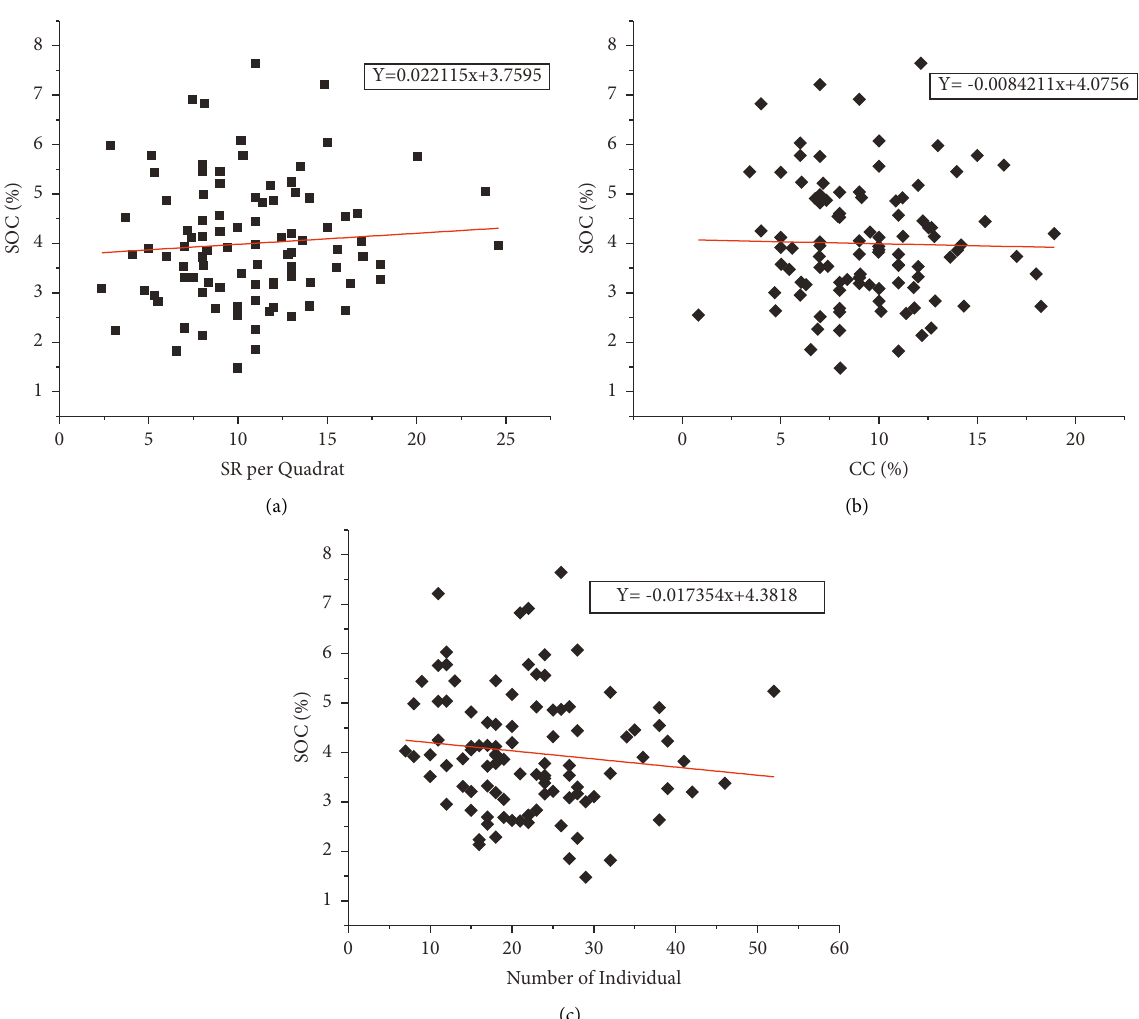
Figure 4: Response of mean SOC (%) against stand structural attributes (CC% � canopy cover percent, number of individuals per plot, SR � plot species richness, x � the independent variable on x -axis, y � the response variable on the y -axis); the dot and line represent observed and fitted values of plots, respectively.